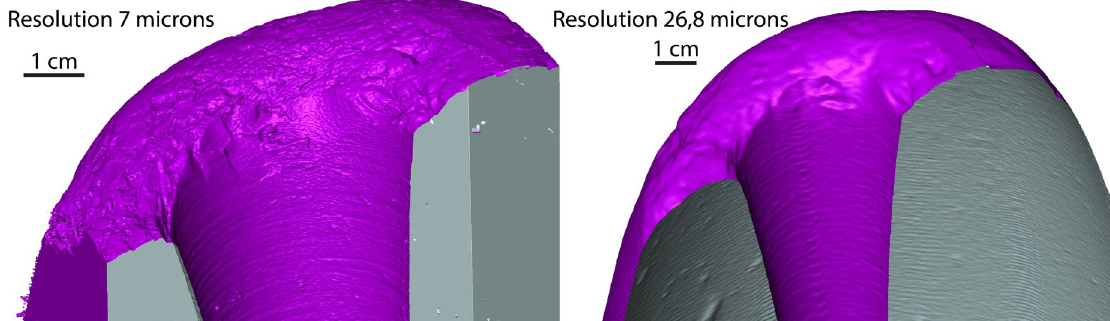
Figure 10: Comparison of visibility of perforation details with two microtomography resolutions on GD-01-003. The resolution with 7 microns per voxels on the left allows to observe the striae, while the resolution of 26.8 microns per voxel on the right allows only to imagine